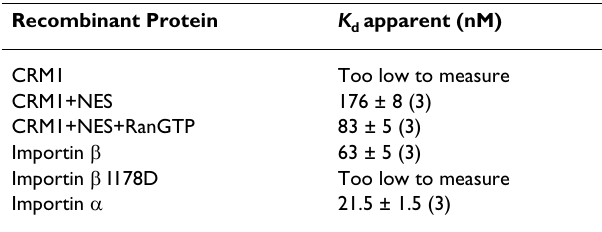
Table 1: Dissociation constants for Tpr interaction with: CRM1, importin β or importin α . Recombinant